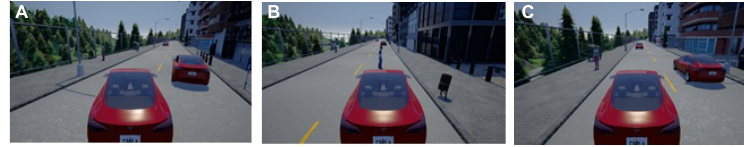
Figure 5. Three example scenarios ( A – C ) self-driving agent’s